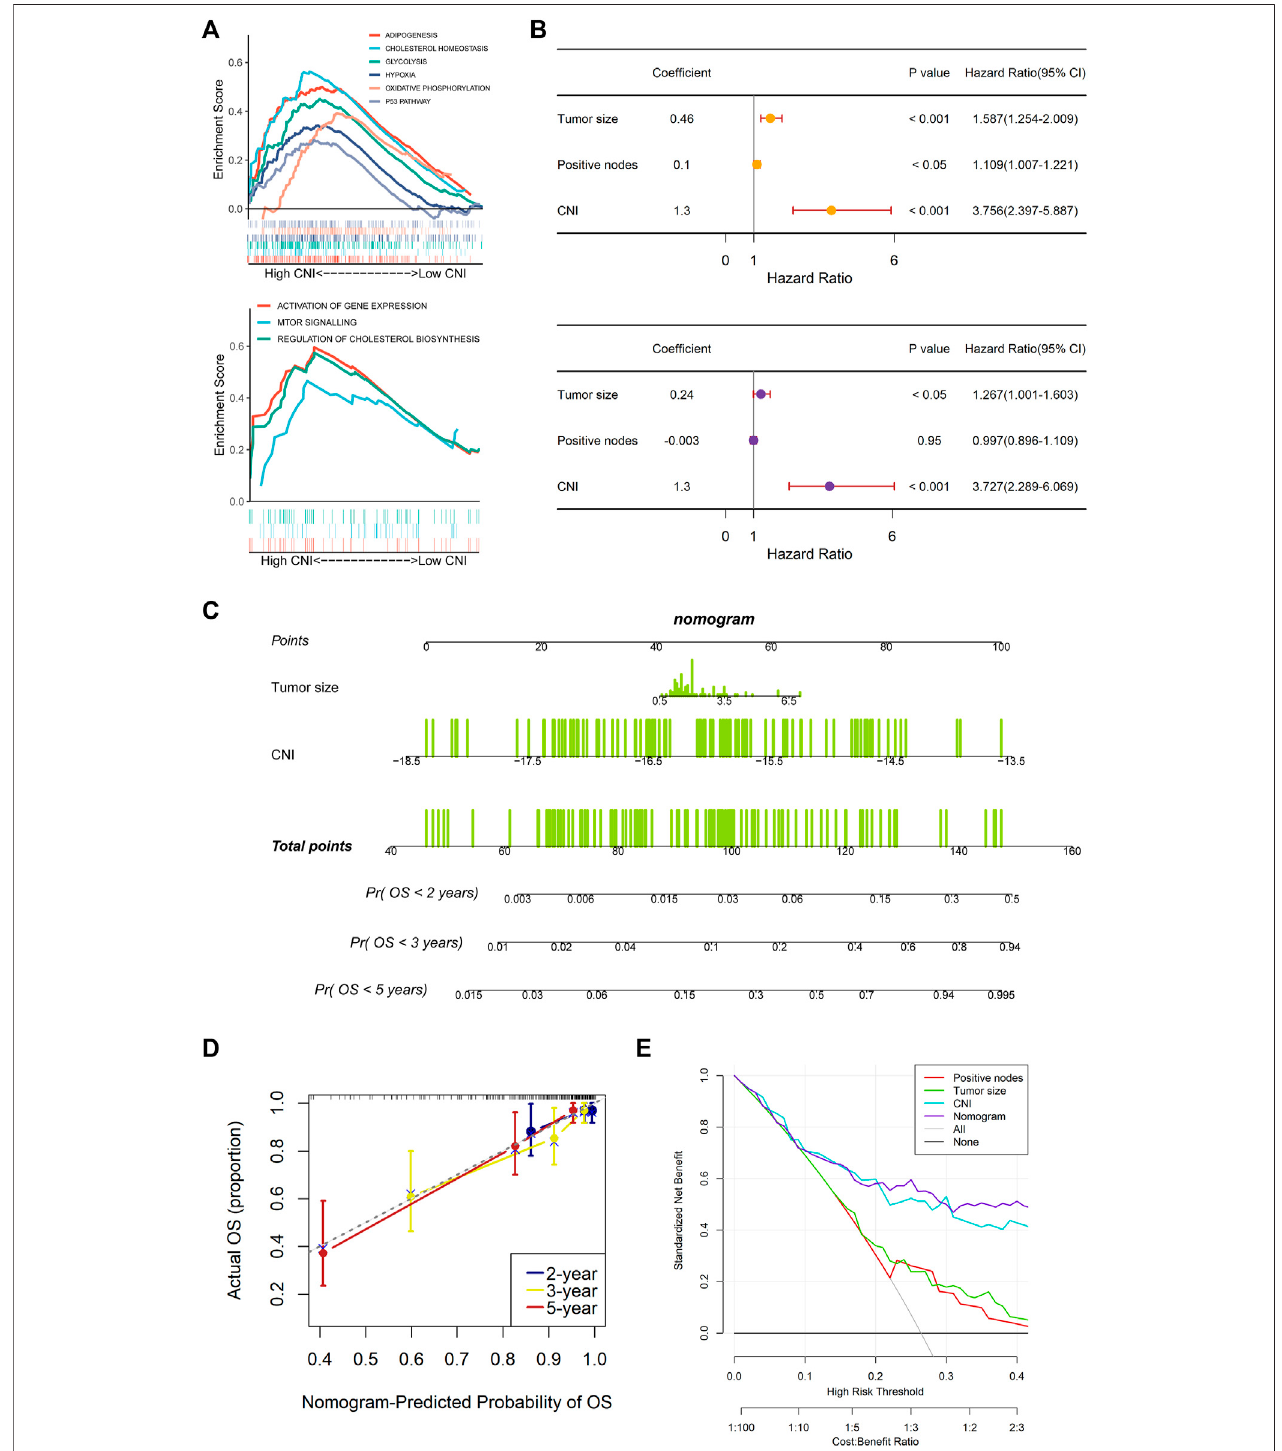
FIGURE6| GeneSetEnrichmentAnalysis(GSEA) andindependently prognostic valueofthenecroptosis-relatedlncRNAs signatureinthetraining set. (A) Results of GSEA in the high-CNI and low-CNI groups based on the necroptosis-related lncRNAs signature. (B) The analysis results of the univariate Cox regression (upper plot) and multivariate Cox regression (lower plot) regarding OS. (C) Construction of a prognostic nomogram to predict 2-, 3-, and 5-year OS in TNBC patients of the training set. (D) Calibration curve plotted in order to evaluate consistency of predicted and actual observations. (E) The DCA curve was plotted to evaluate the clinical decision-making bene fi ts of the